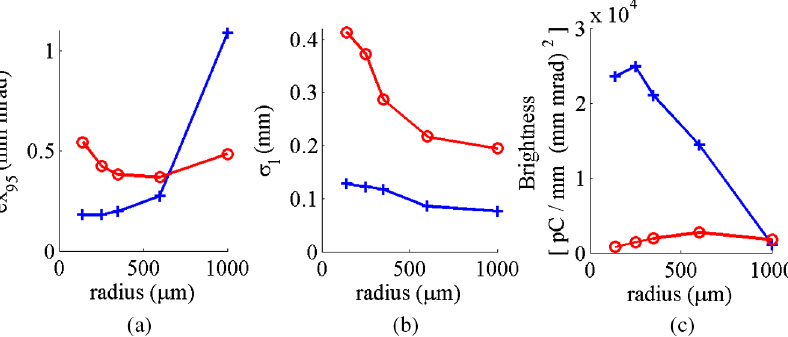
FIG. 9. Results from 100 pC bunch charge parameter scans as a function of the laser spot size radius where the blue crosses are for X-band ( 200 MV = m cathode field) and the red circles are for S-band ( 120 MV = m cathode field}: (a) minimum 95% transverse emittance, (b) minimum bunch length and (c) maximum peak